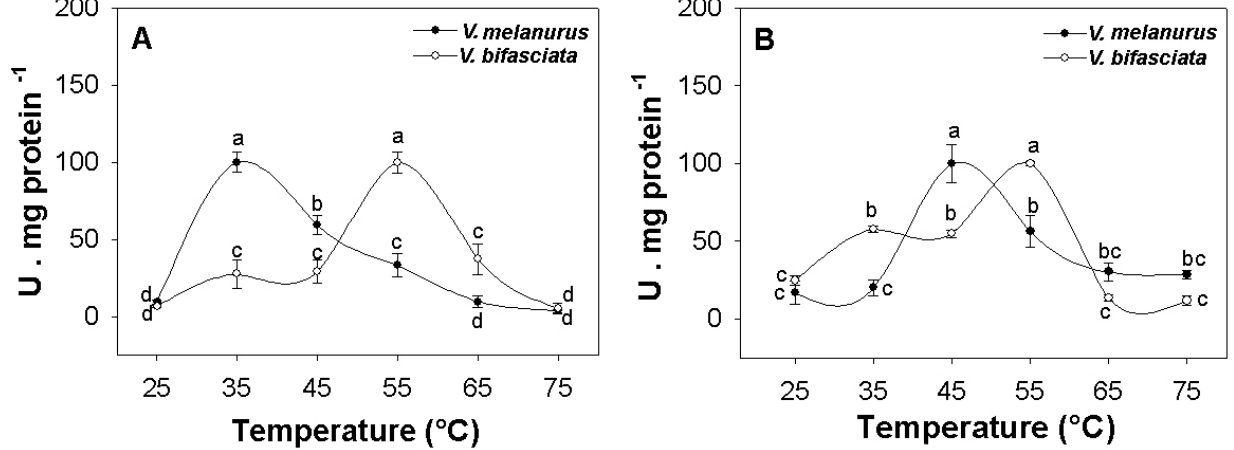
FIGURE 3 | Effect of optimal temperature (mean ± SD, n = 3) on A . acid proteases and B . alkaline proteases of Vieja melanurus and V. bifasciata. Significant differences (P< 0.05) between pH values are shown by